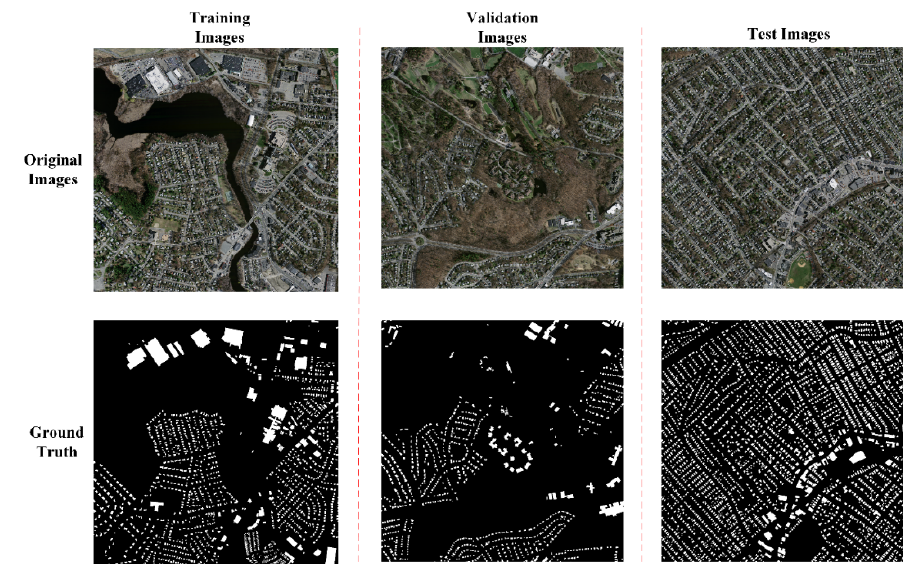
Figure 2. Several sample images in the original Massachusetts Building dataset for training, validation and testing, respectively.